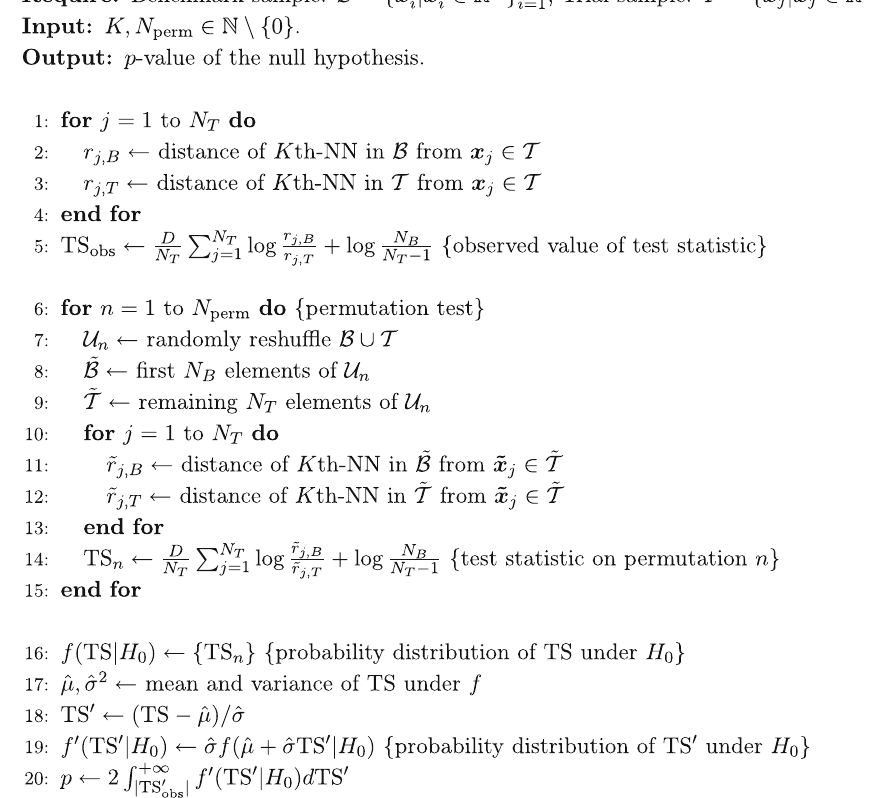
Table 1 Pseudo-code for the two-sample test algorithm, using nearest neighbors density ratio